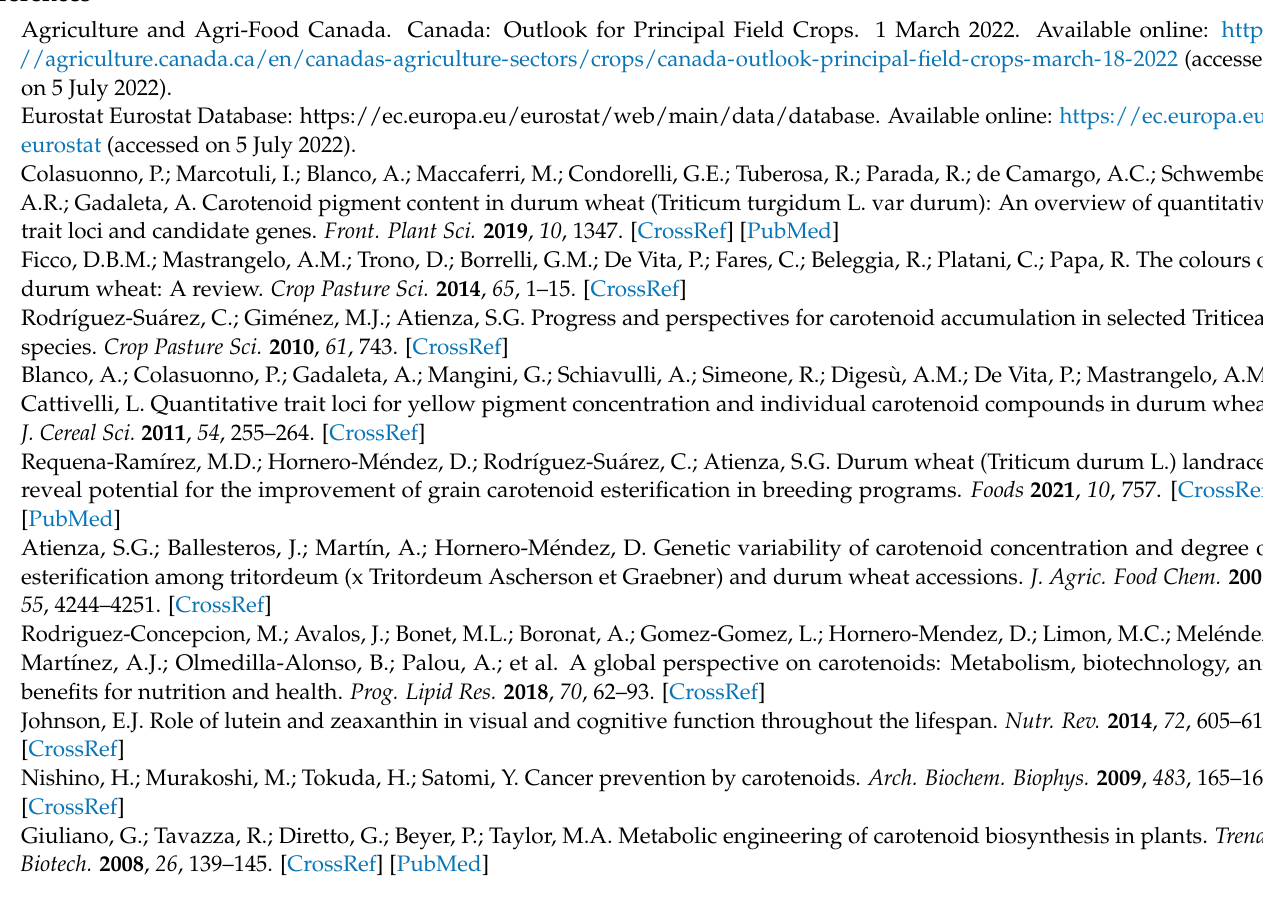
Table S2. ‘Svevo’ gene models matching MTA described in this work. Table S3: List of accessions analyzed in this